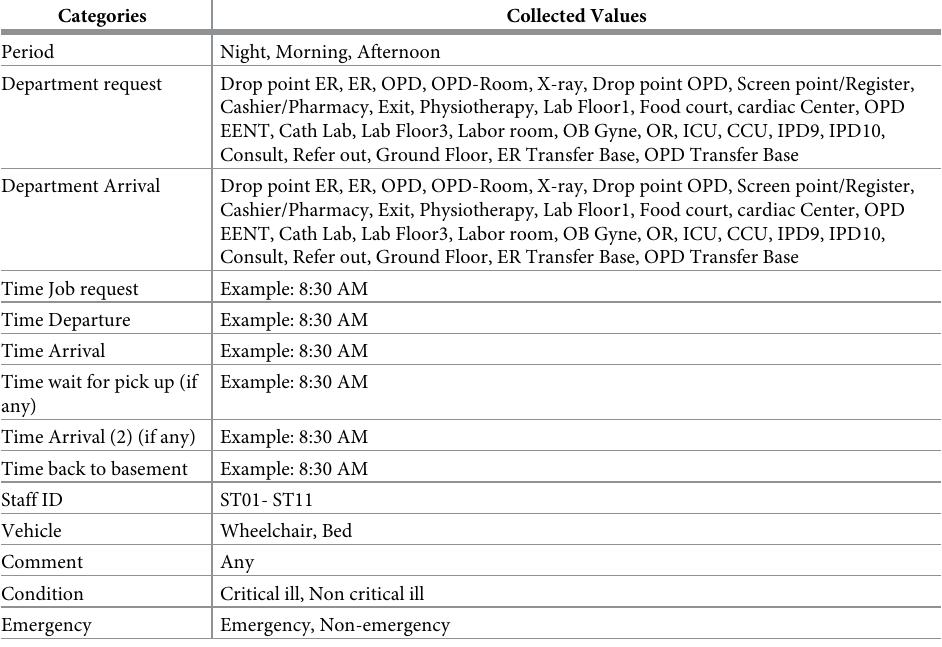
Table 1. Data collection for simulation modeling. Categories Collected